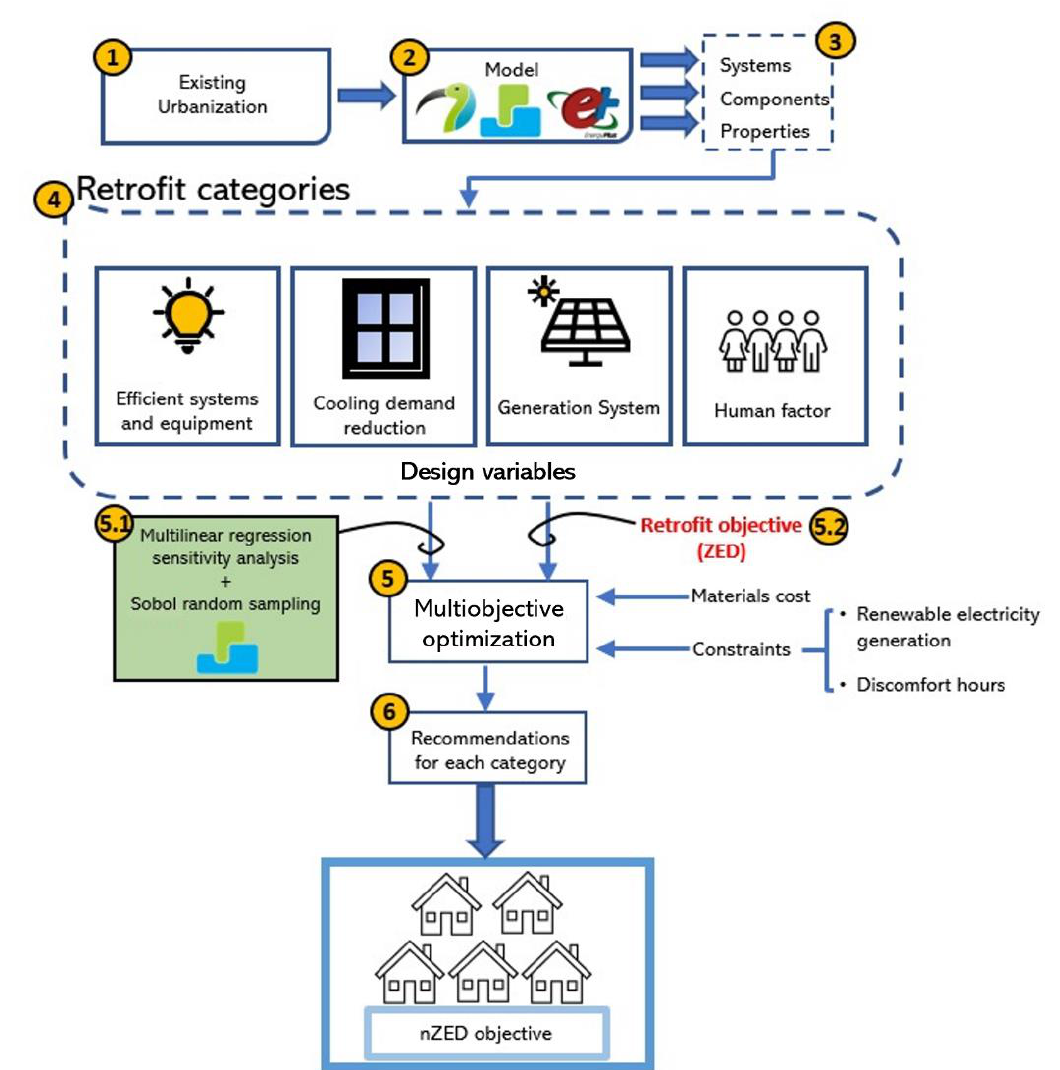
Figure 5. Diagram of the methodology followed in the study.